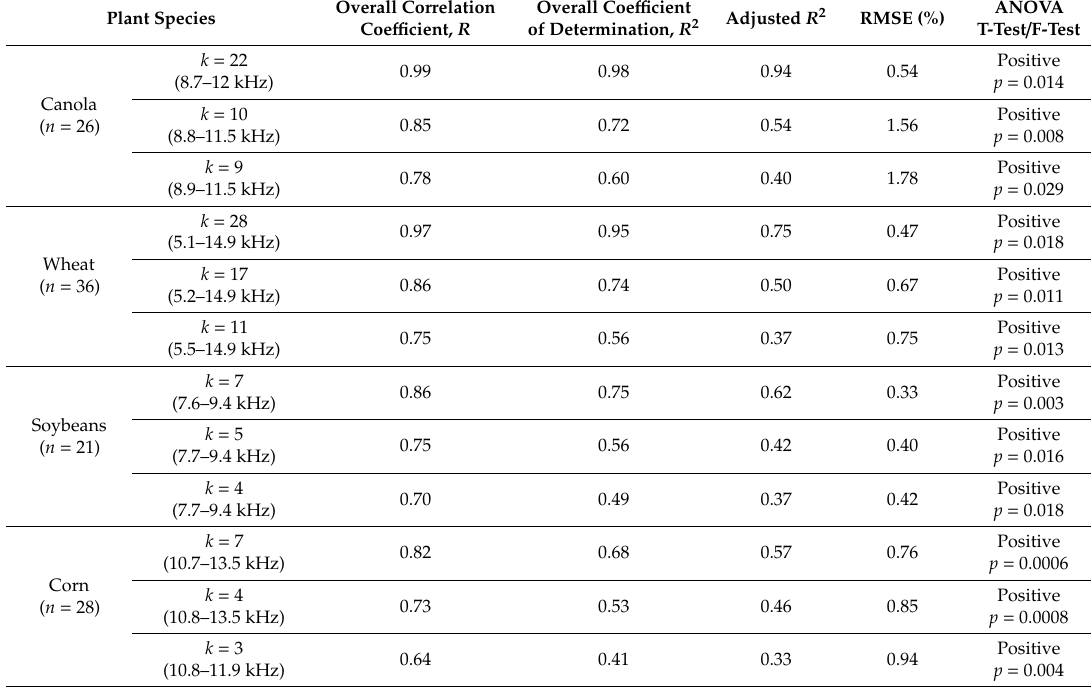
Table 2. Multiple linear regression analysis for four di ff erent plant species with nitrogen concentrations considering probability, p ≤ 0.05 (probability of rejection of null